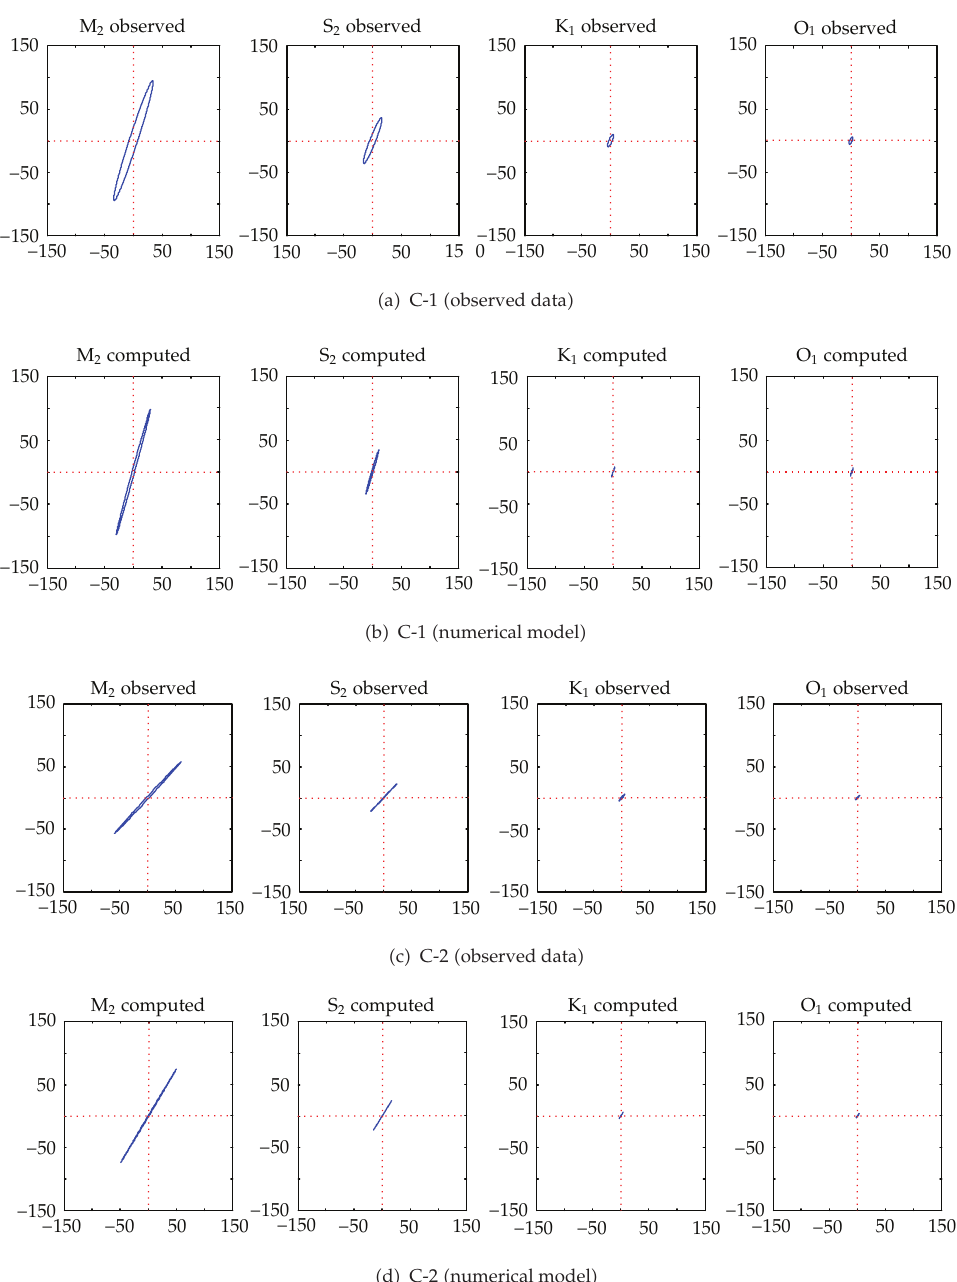
Figure 6: Comparison of observed and predicted tidal